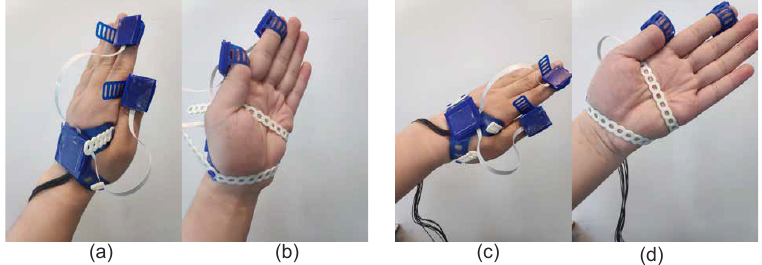
Figure 2. Movement for task 1: rotations of the hand, while not varying relative orientations between the hand and fingers. Subfigure ( a , b ) are a set of pronation and supination movements. Subfigure ( c , d ) are another set of pronation and supination but with a different rotation axis. During this task, we did the pronation and supination movements with different rotation axes.